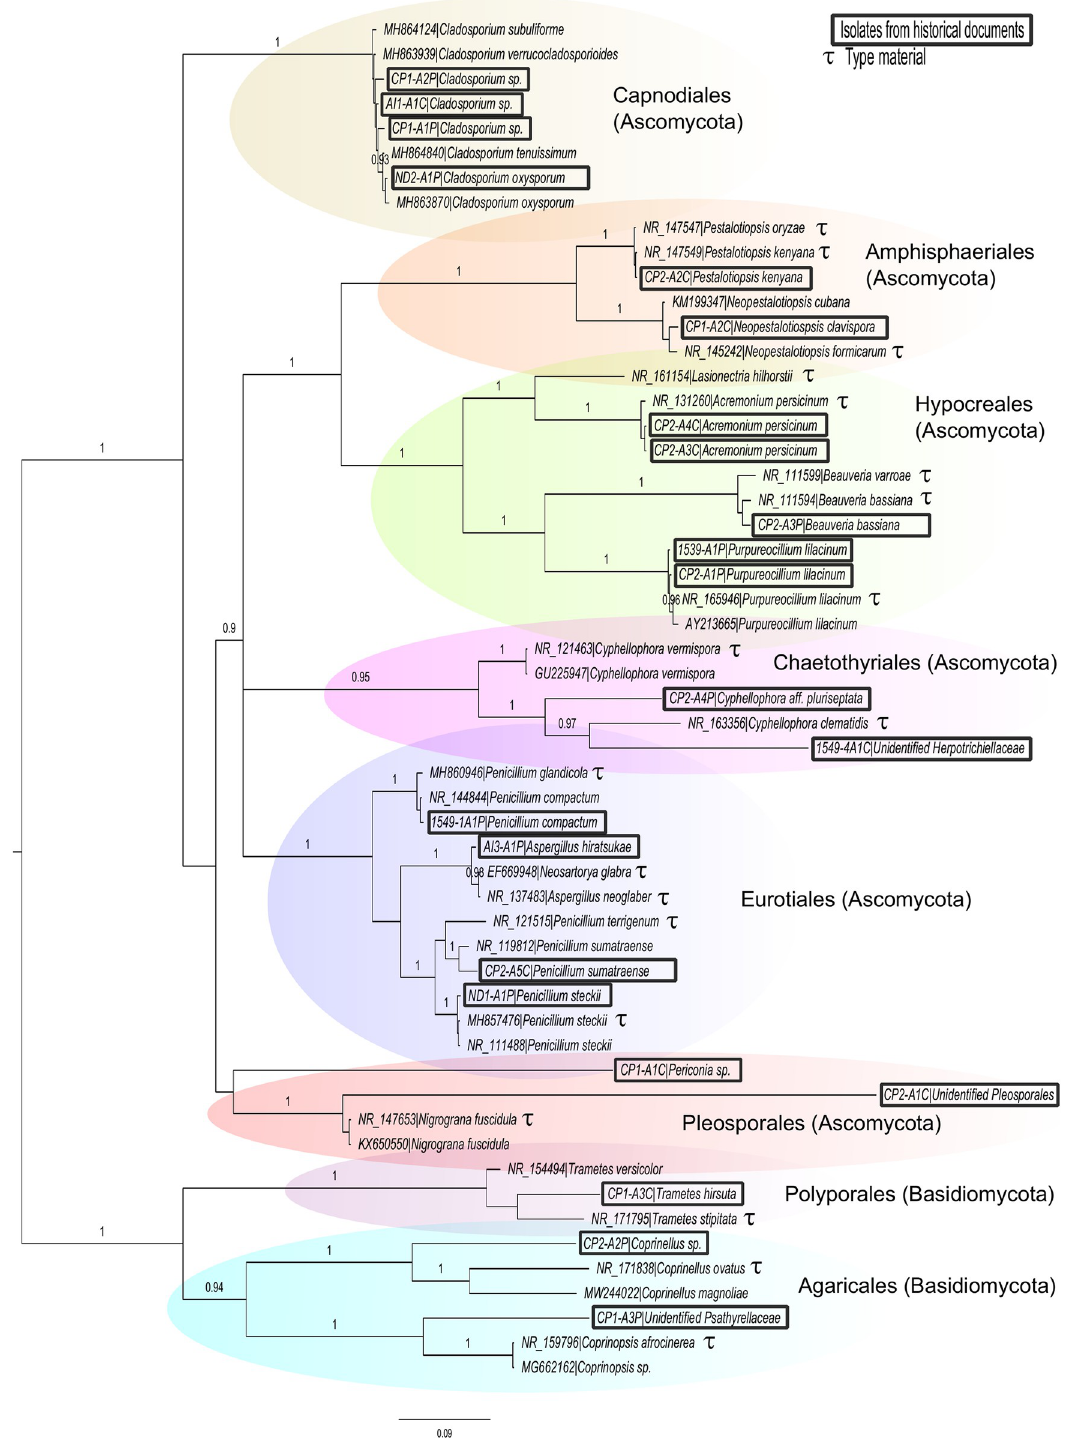
Fig 2. Bayesian inference consensus cladogram based on nrDNA ITS sequences. Posterior probabilities are indicated at branches. LnL = -13564.21.